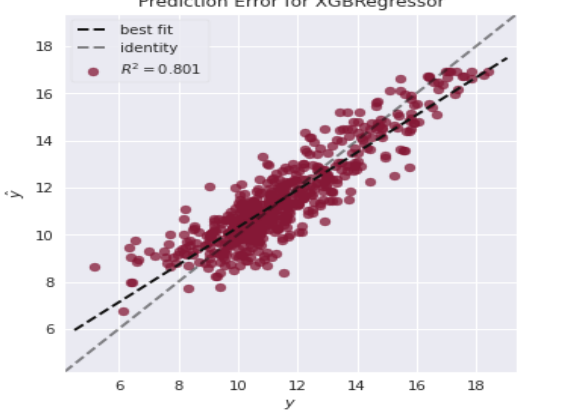
Figure 3 Prediction Error for